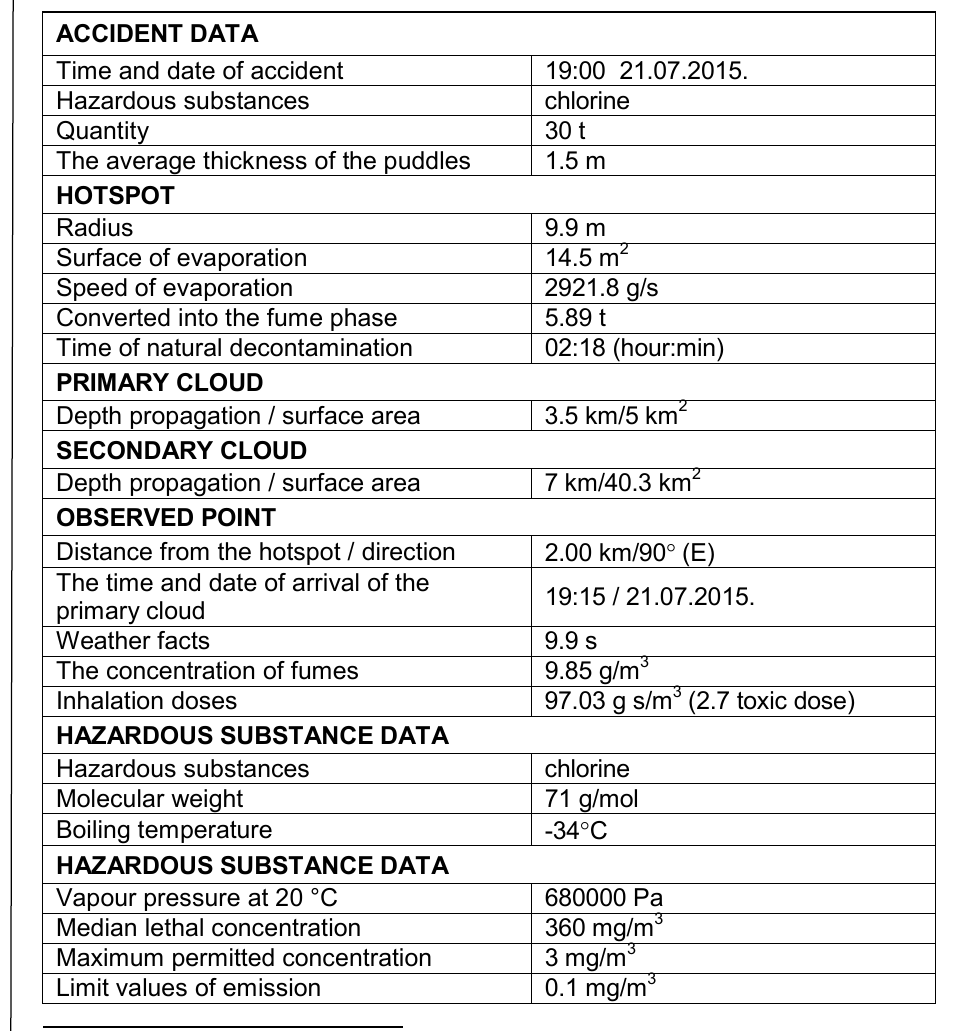
Table 2 – Data on a designed terrorist attack on a chemical facility Таблица 2 – Данные о смоделированном теракте на объекте химической промышленности Tabela 2 – Podaci o modelovanom teroristi č kom napadu na objekat hemijske